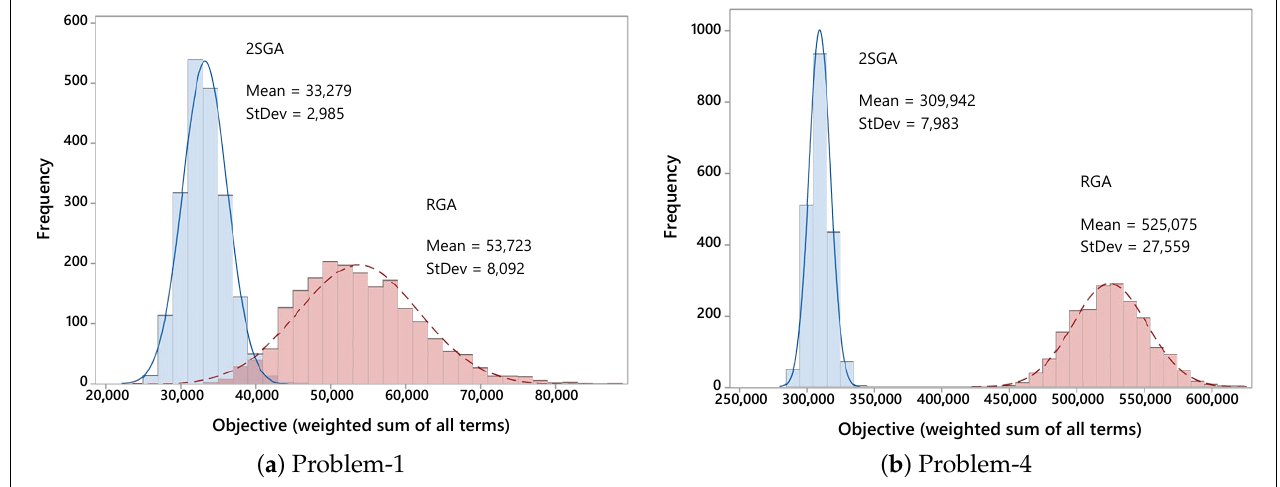
Figure 11. The distribution of the objective function of the initial populations of 2SGA and RGA in both Problem-1 and Problem-4.